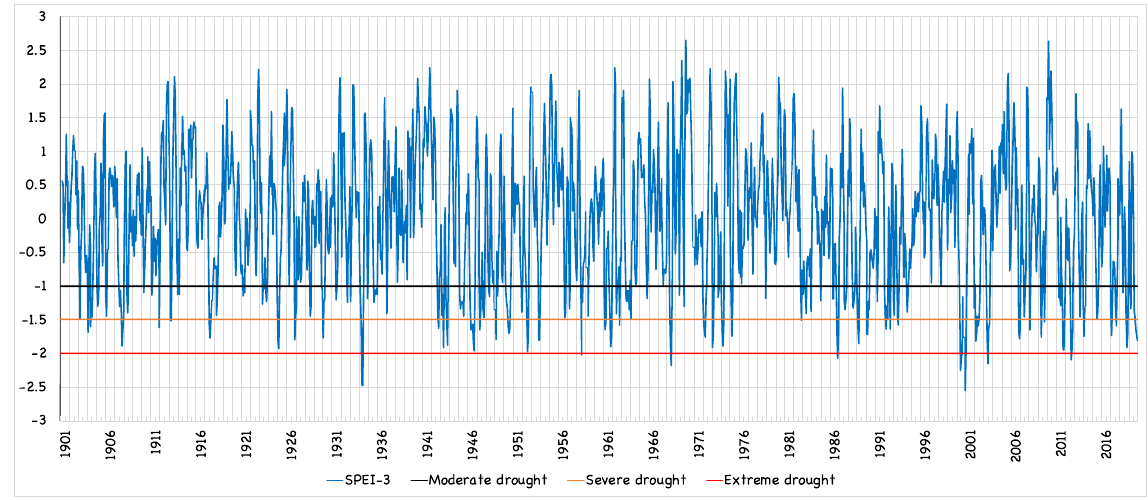
Figure 5. Variation of standardized precipitation evapotranspiration index (SPEI) across the analyzed period.